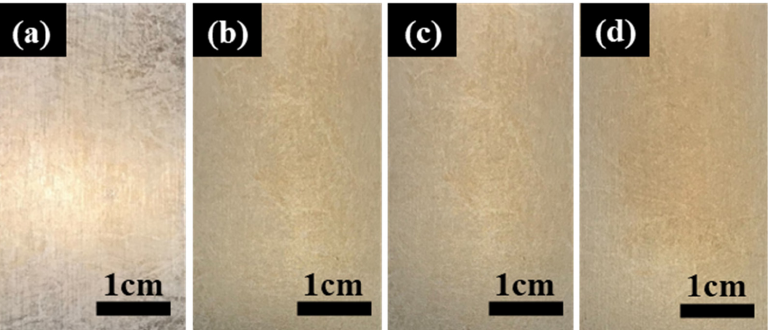
Figure 1. Optical images of LZ91 Mg alloy after acid pickling pretreatment for ( a ) 30 s, ( b ) 60 s, ( c ) 90 s, and ( d ) 120 s. Figure 2 shows the SEM microstructure of LZ91 Mg alloy for different immersion times in the acid pickling pretreatment. After acid pickling pretreatment for 30 s, the sur- face is homogeneous and slightly undulated (Figure 2a,b). The surface becomes more ho- mogeneous and has irregular light and dark patches, as shown in Figure 2e,g.